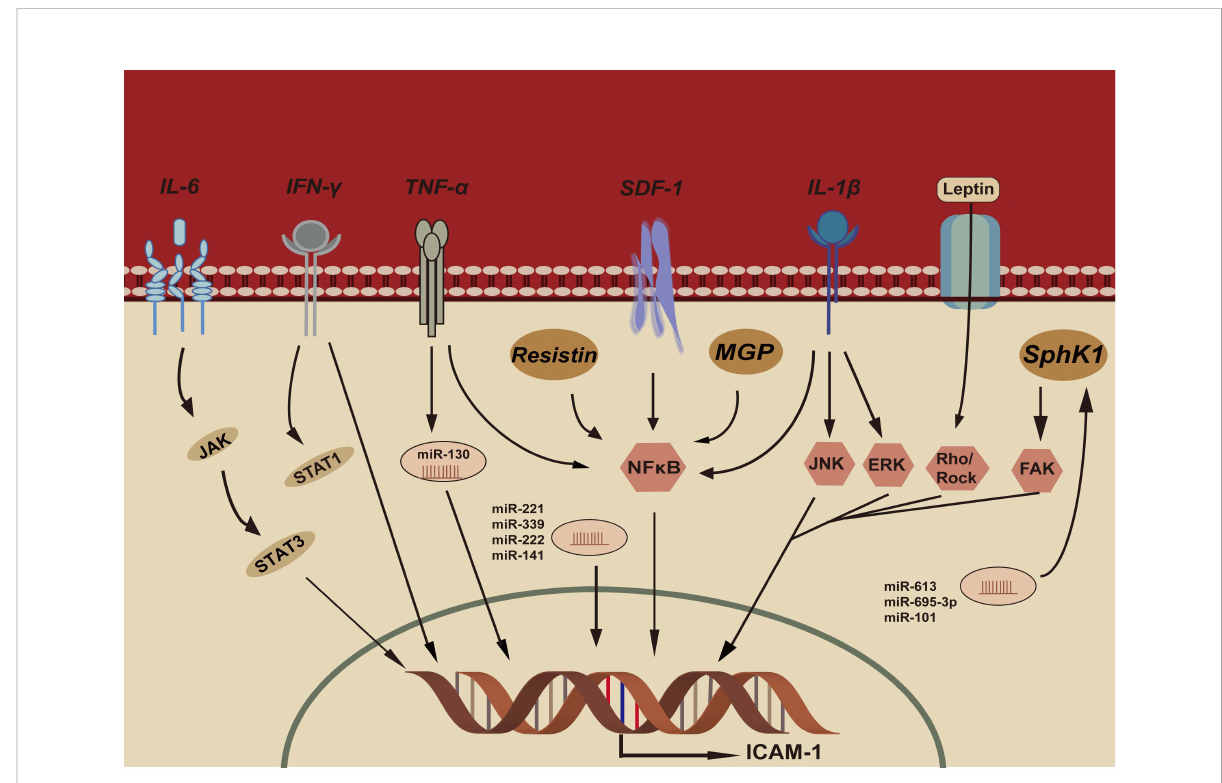
FIGURE 1 IL-6, Interleukin-6; IFN- g , Interferon- g ; TNF- a , Tumor necrosis factor- a ; SDF-1, Stromal cell derived factor-1; IL- b , Interleukin- b ; MGP, Matrix gla protein; SphK1, Sphingosine kinase-1; JAK, Janus kinase; STAT3, Signal transducer and activator of transcription 3; STAT1, Signal transducer and activator of transcription 1; NF k B, NF k B pathway; JNK:c-Jun N-terminal kinase pathway; ERK, Extracellular signal-regulated kinase pathway; FAK, Focal adhesion kinase pathway; Rho/Rock, Rho/Rho-associated kinase pathway; ICAM-1, Intercellular adhesion